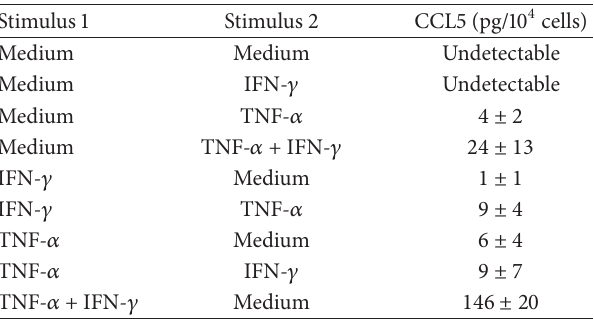
Table 1: Effect of sequential addition of TNF- 𝛼 and IFN- 𝛾 on CCL5 release by